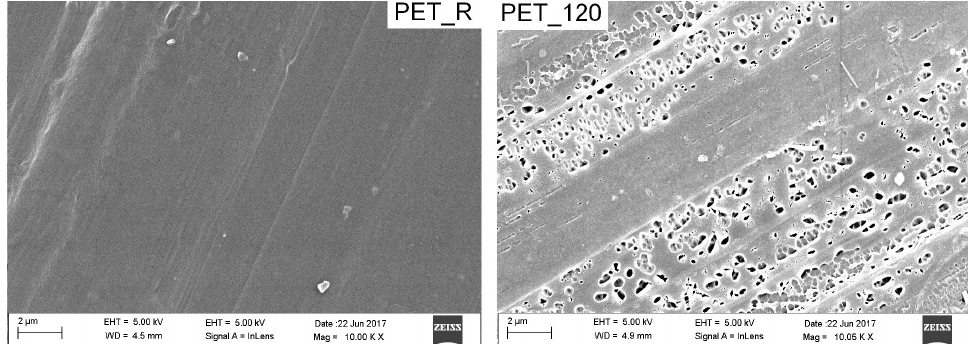
Figure 2. SEM images of reference (left) and modified (right) PET fiber.